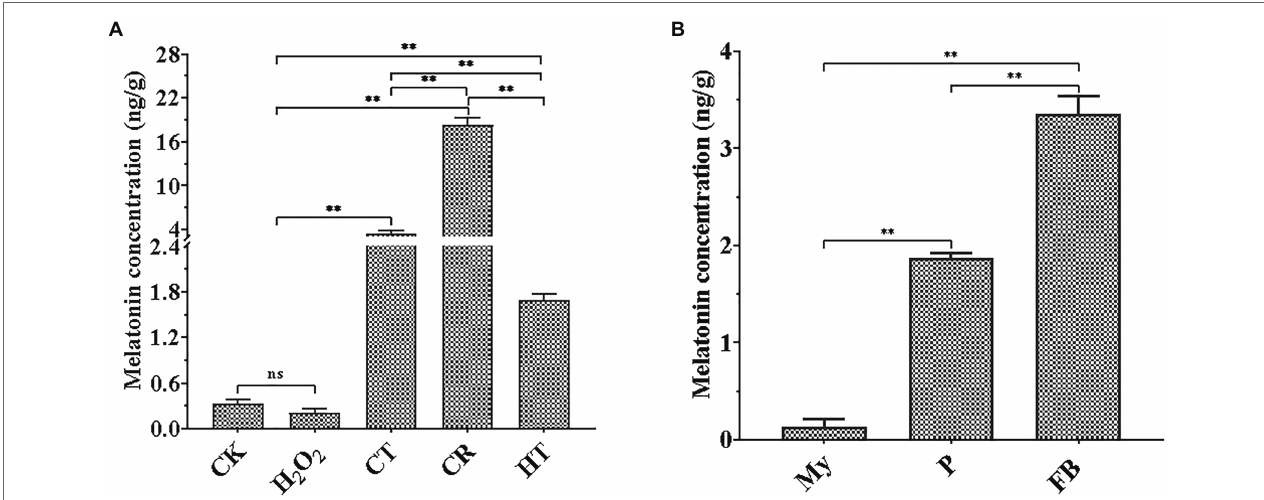
FIGURE 1 | Quantification of melatonin production in T. guangdongense at different abiotic stressors (A) and developmental stages (B) . CK, mycelia untreated by several abiotic stresses; H 2 O 2 , H 2 O 2 stress; CT, cold stress; CR, congo red stress; My, mycelial stage; HT, heat stress; P, primordial stage; FB, fruiting body stage; ** , highly significant differences ( p <